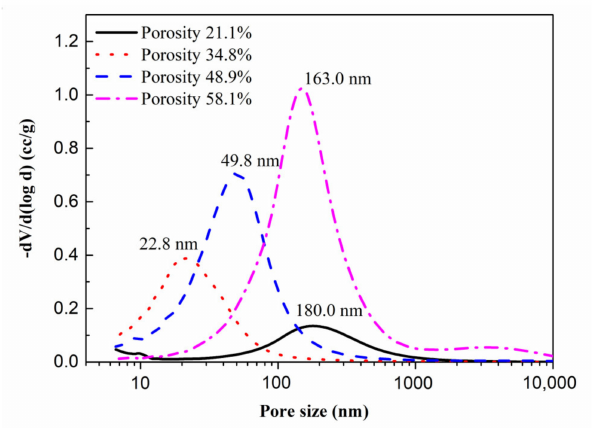
Figure 9. Pore size distribution of porous MOS cement paste.